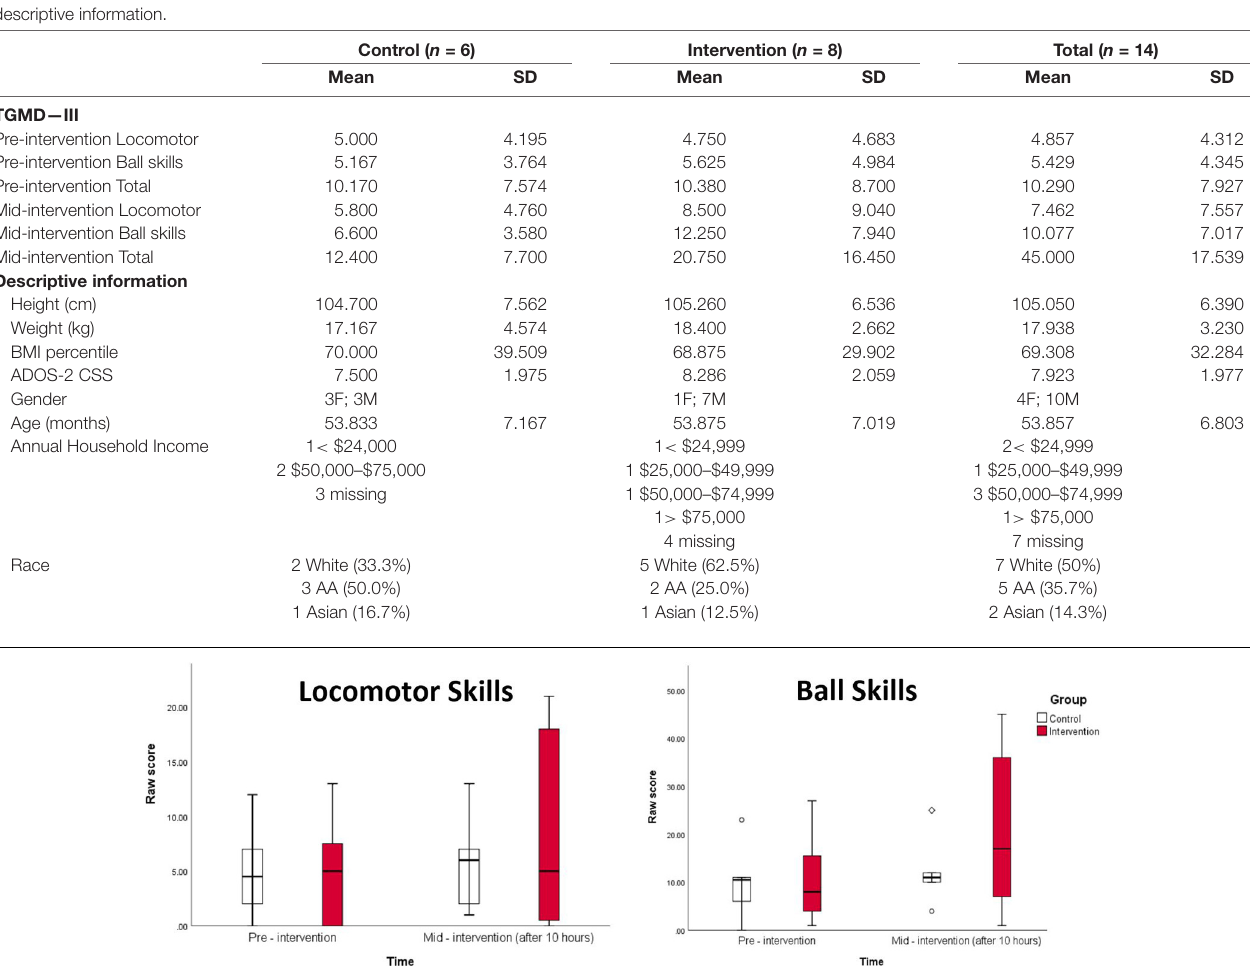
FIGURE 1 | Box-and-whisker plots of total, locomotor, and ball skill raw scores by interventional group at baseline and mid-intervention. Higher scores indicate better motor performance.